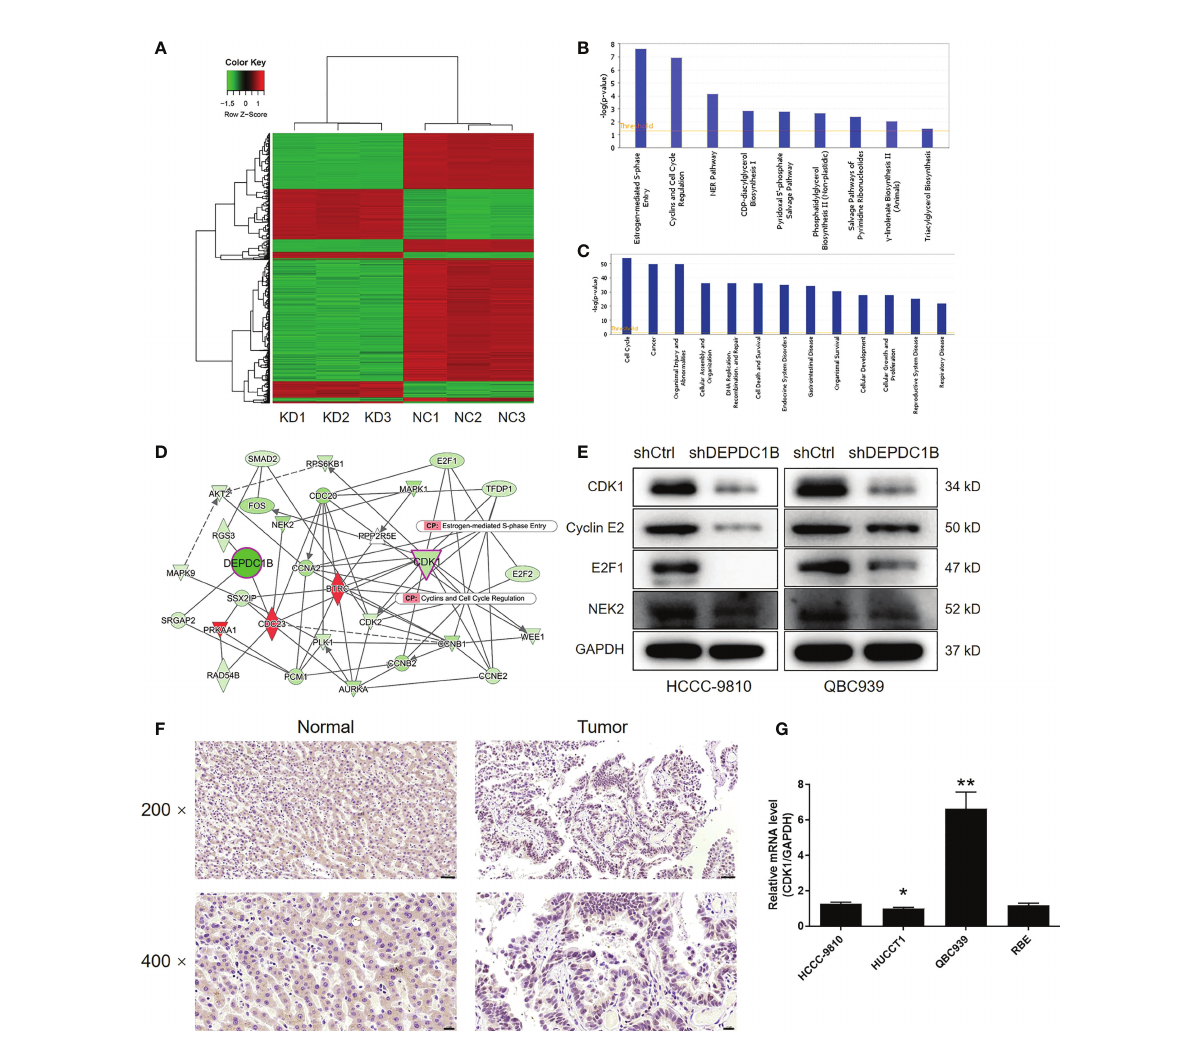
FIGURE 4 The exploration and veri fi cation of downstream underlying DEPDC1B-induced regulation of CCA. (A) A PrimeView Human Gene Expression Array was performed to identify the differentially expressed genes (DEGs) between the shDEPDC1B and shCtrl groups of HCCC-9810 cells. (B, C) The enrichment of DEGs in the canonical signaling pathway (B) and IPA disease and function (C) was analyzed by IPA. (D) A DEPDC1B- associated interaction network constructed by IPA revealed the potential linkage between DEPDC1B and CDK1. (E) Western blotting was used to detect the expression of several selected DEGs in HCCC-9810 and QBC939 cells with or without DEPDC1B knockdown. (F) The expression of CDK1 in CCA tissues and normal tissues was evaluated by IHC analysis (scale bar = 50 m m for ×200, 20 m m for ×400). (G) The mRNA expression of CDK1 in HUCCT1, QBC939, RBE. and HCCC-9810 cell lines was detected by qPCR. The representative images were selected from at least three independent experiments. Data were shown as mean ± SD (n = 3). * P < 0.05, ** P <